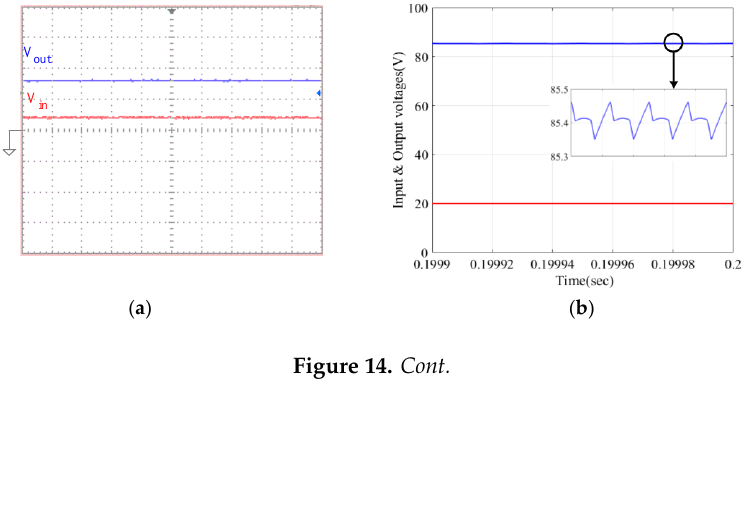
Figure 13. Switch gate signals S 1 and S 2 (Volt/div=5V, Time/div=10µs). D t =0.6 and D s =0.2 .